Question: What form of chart is displayed?
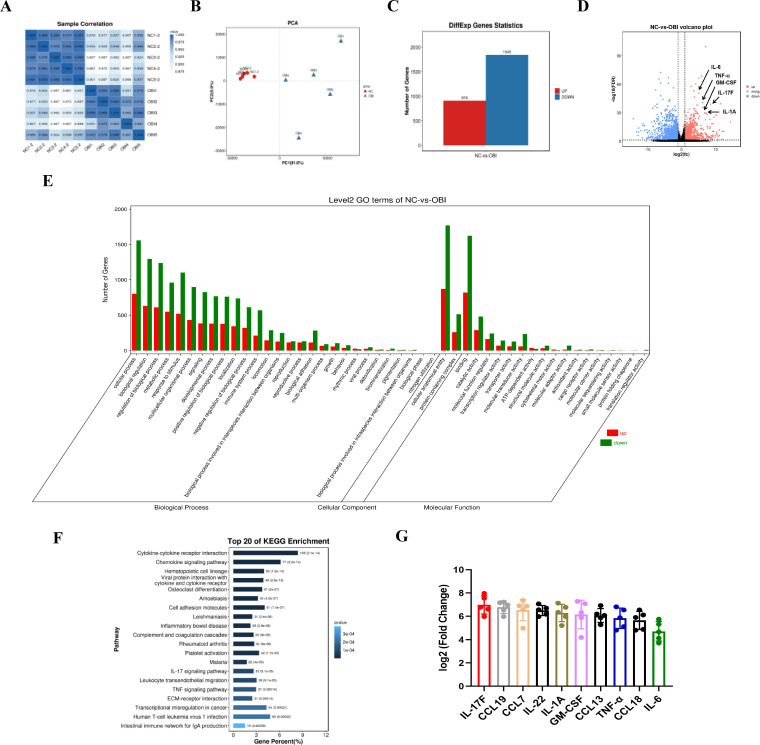
Answer: heatmap